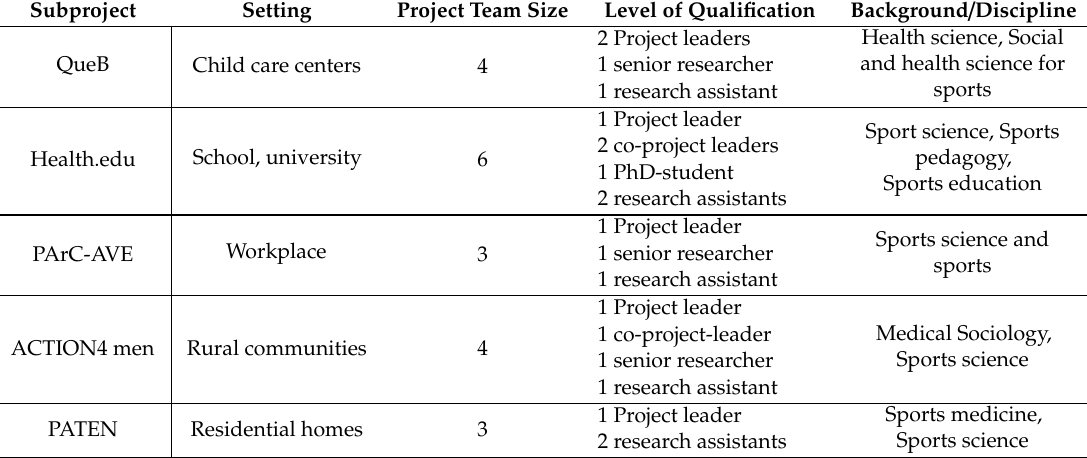
Table 3. Characteristics of the scientific members of the five